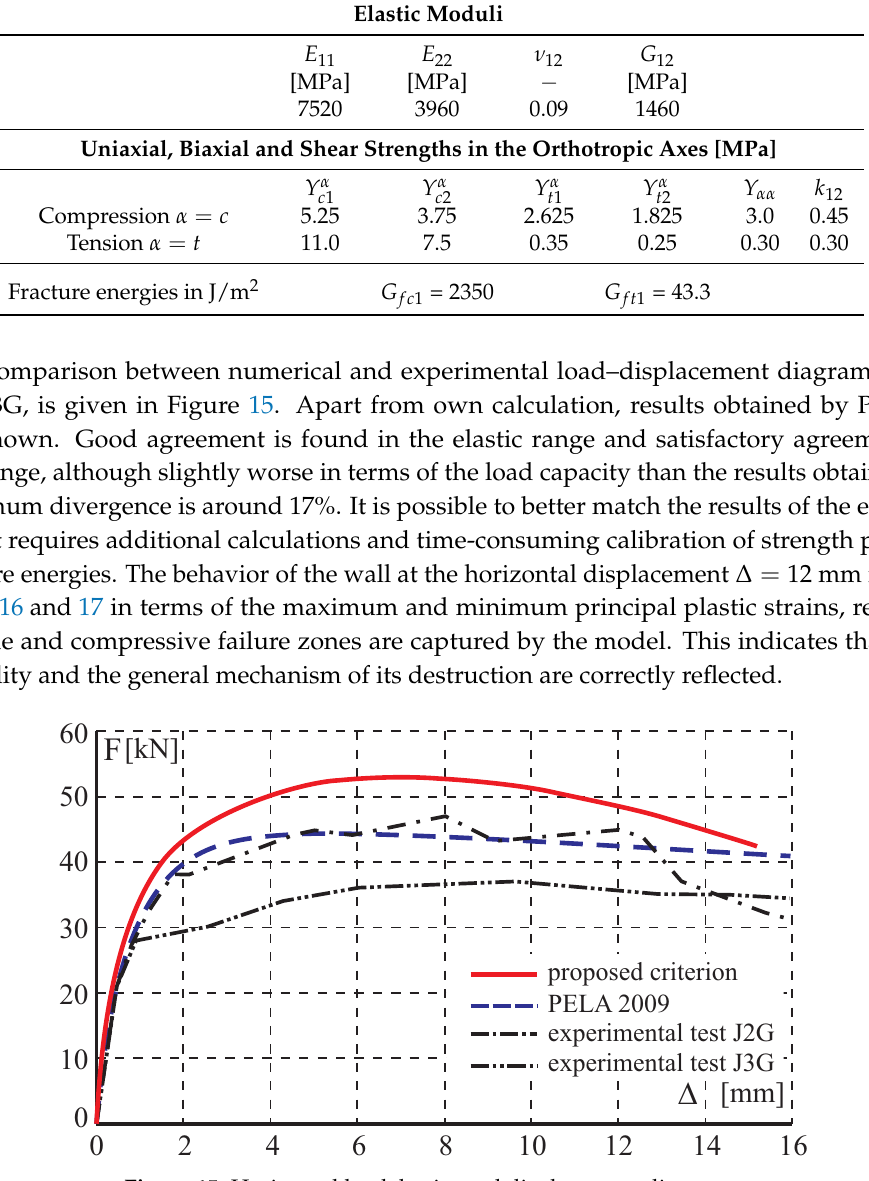
Figure 15. Horizontal load–horizontal displacement